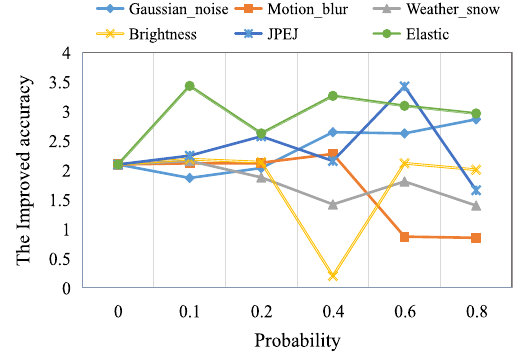
Fig. 10 The accuracy of the proposed method, trained with the ResNet-110 network and different given probability. The maximum accuracy is 75.98 if P c = 0.1. The baseline is 74.71, as the gray dotted line has